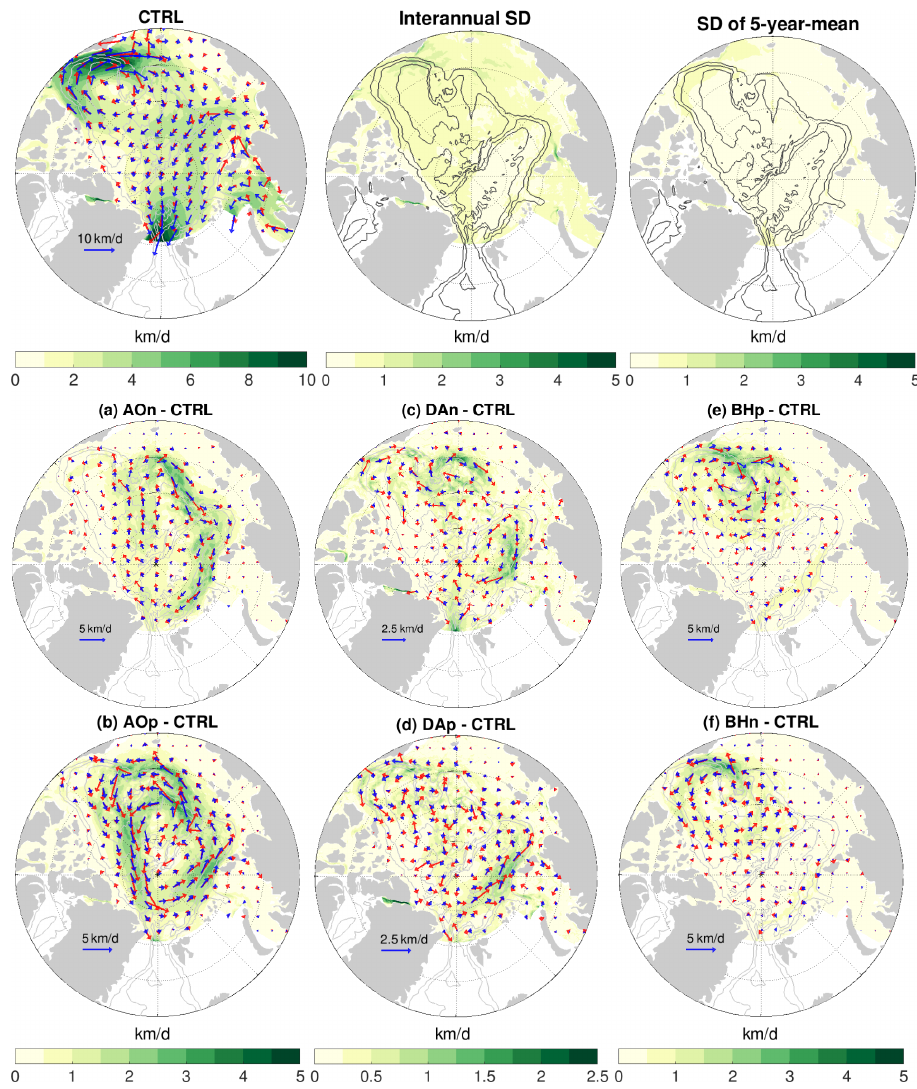
Figure 6. (a–f) Anomaly of sea ice drift (blue arrows) and ocean surface geostrophic current (red arrows) averaged over the 4 model years of the sensitivity simulations in which wind perturbations were switched off: experiments with an initial ocean spun up with the (a) negative phase of Arctic Oscillation (AO) forcing, (b) positive phase of AO forcing, (c) negative phase of Dipole Anomaly (DA) forcing, (d) positive phase of DA forcing, (e) positive phase of Beaufort High (BH) forcing and (f) negative phase of BH forcing. The magnitude of the ice drift anomaly is also shown with color. The anomalies are referenced to the control run. The mean sea ice drift in this period (left), the standard deviation (SD) of sea ice drift speed on the interannual timescale in the 2010s (middle) and the SD of the pentadal mean in the period 1980–2019 (right) from the control run are shown at the top of the figure for reference. Note that the scaling for velocity arrows and the range for color are different in different panels, but in each panel the same scaling is used for sea ice drift and geostrophic current. The gray contour lines indicate the 500, 2000 and 3500m